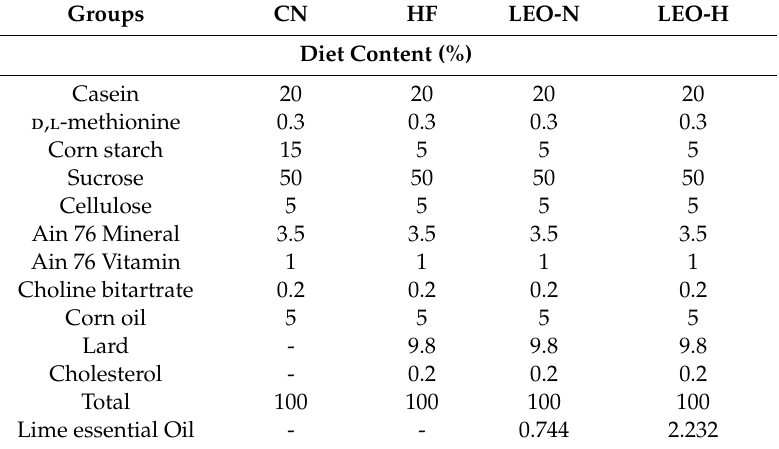
Table 1. The animal feed formula for testing the regulation of hypolipidemic and body fat and the e ff ects of lime on body weight and food e ffi ciency of the high-fat diet of Wistar rat. Groups CN HF LEO-N LEO-H Diet Content (%)